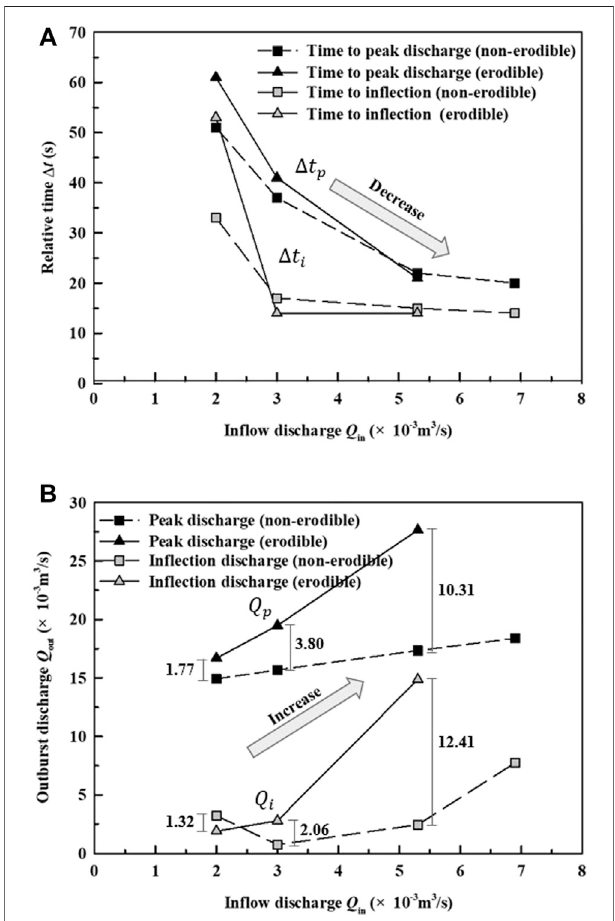
FIGURE 9 | In fl uence of upstream fl ow discharge on (A) the time to in fl ection discharge and peak discharge and (B) the outburst discharge of dams with erodible beds (Test Nos. E-Q2.0, E-Q3.0, E-Q5.3) and those with non-erodible beds (Test Nos. N-Q2.0, N-Q3.0, N-Q5.3,